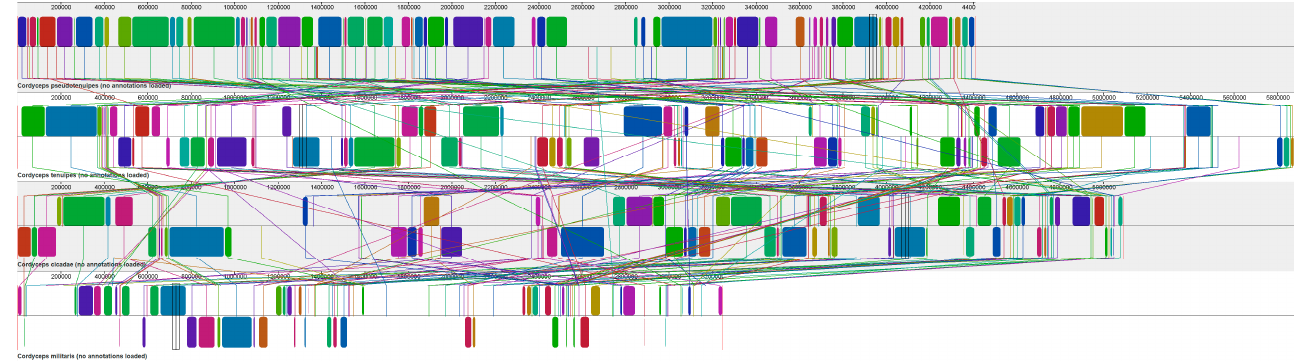
Figure 9. Scaffold containing secondary metabolite biosynthesis gene cluster used for synteny anal-